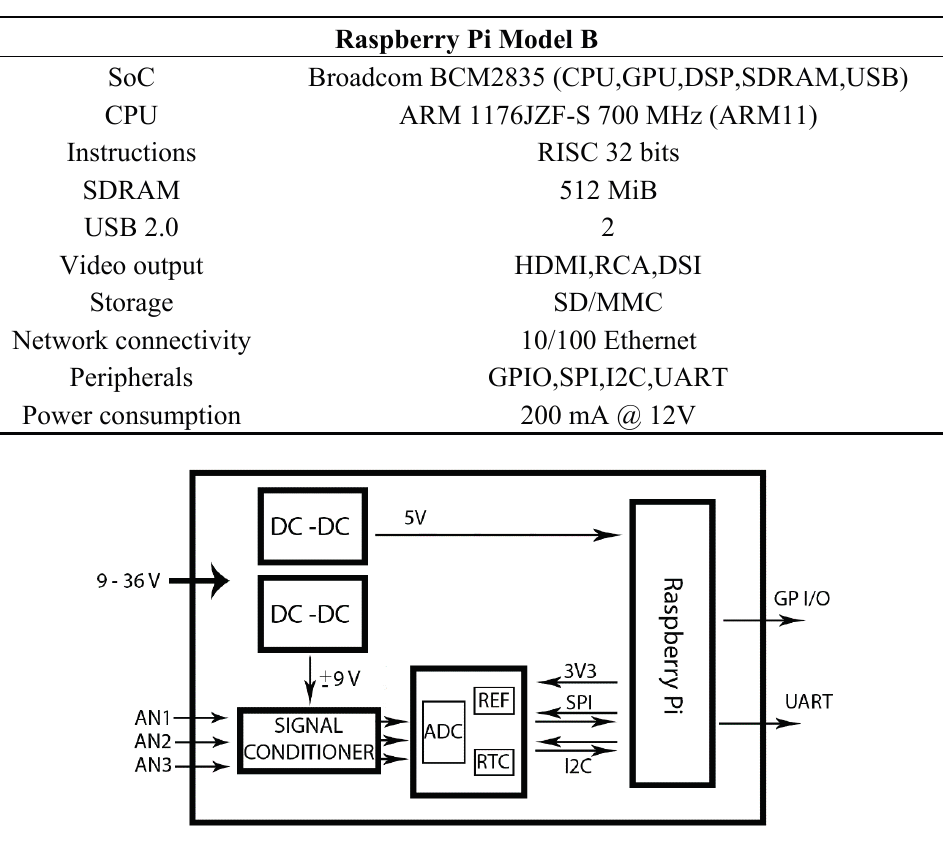
Figure 1. General schema.